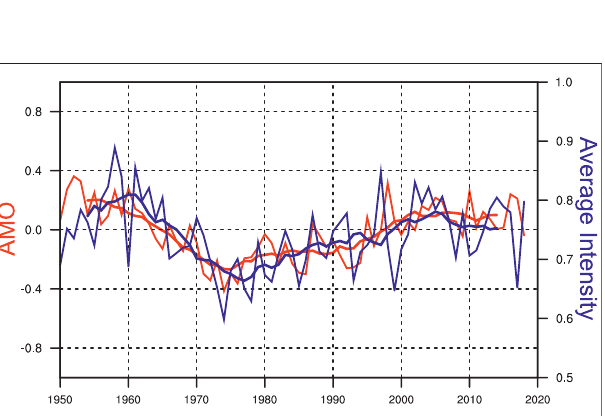
FIGURE 2 | Time series of annual mean average intensity (thin blue curve; unit: 10 2 · knot ) and the AMO index (thin red curve; unit: K) for 1950 – 2018. The thick curves show the 9-year running averages. The long- term linear trends were removed.